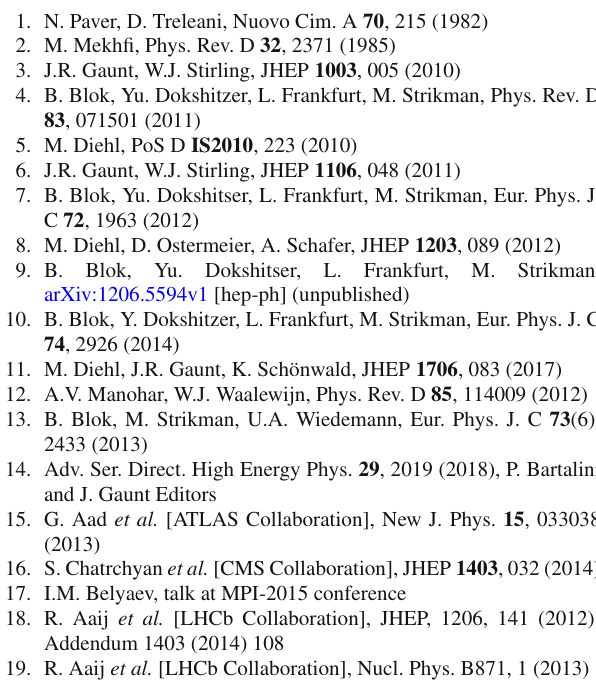
methodtobeusedalreadywith2016recordeddata.Moreover the distribution in lepton charge asymmetry has the poten- tial to uncover correlations in double 2 GPD of the nucleon beyond the mean field approximation. The Wb having lower rate, can still be used at the inclusive level to search for the DPS2 contribution in the future runs, albeit with reduced sensitivity relative to W j j final state. The obser- vation of the ssW W final state, being a clean but a rare pro- cess, will depend crucially on the running conditions of the future pA runs and upon the W -reconstruction experimental